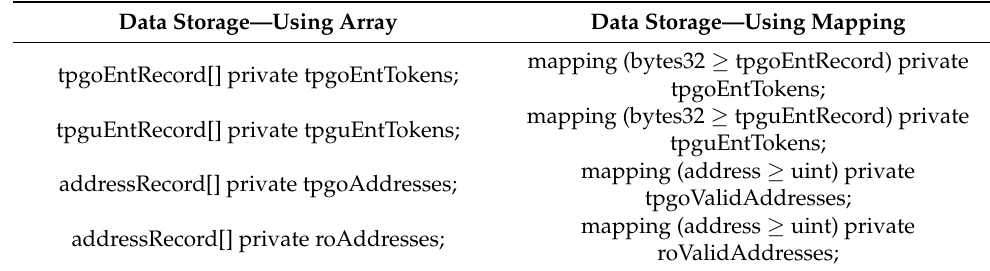
Table 3. Data storage alternative considerations. Data Storage—Using Array Data Storage—Using Mapping